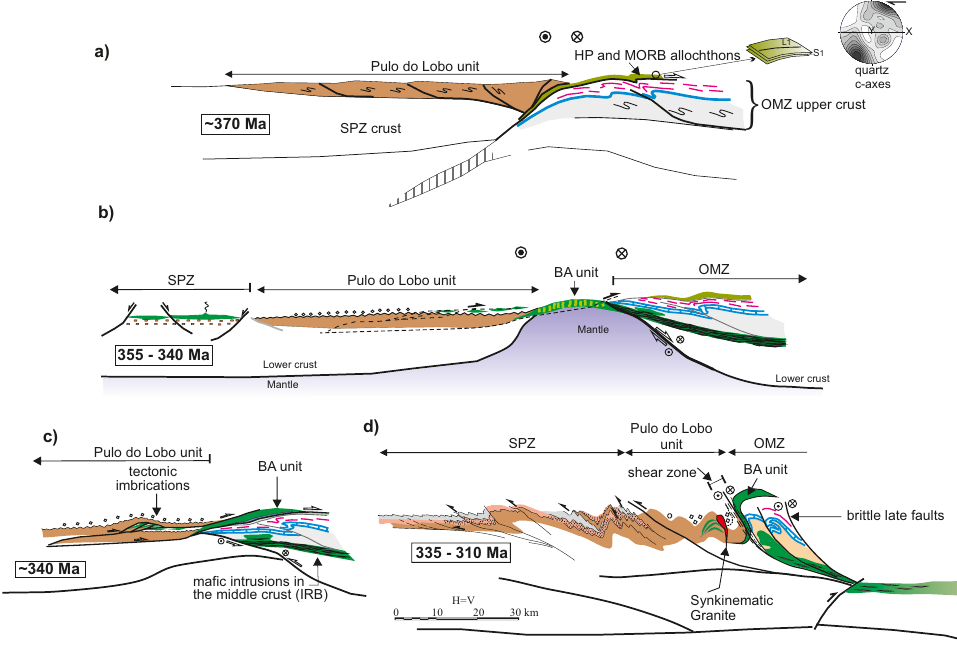
Figure 2. Evolutionary model for the OMZ–SPZ boundary from the Middle–Late Devonian to the Pennsylvanian proposed by Pérez-Cáceres et al. (2015). (a) Closing of the Rheic Ocean and Late Devonian collision. (b) Early Carboniferous intracollisional transtensional stage mainly represented by the metamafic BA unit. (c) Carboniferous renewed oblique collision, producing the obduction of the BA unit onto the OMZ. (d) High- to low-temperature folding and shearing of the BA unit and southwards propagation of the deformation. Notice that the left-lateral component of displacements, indicated by standard symbols, cannot be included in these cross